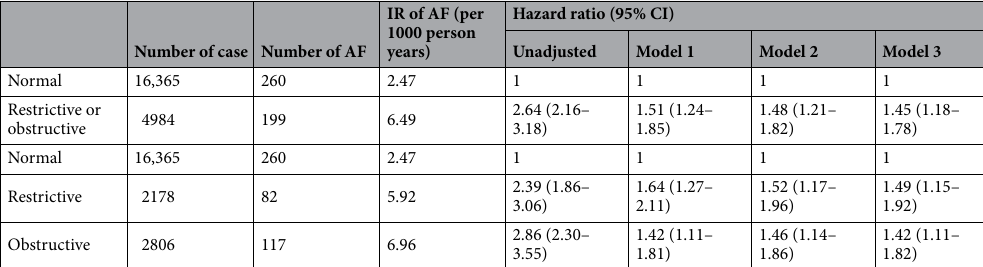
patients with obstructive or restrictive lung function impairment had a 1.4-fold higher AF incidence than those with normal lung function.